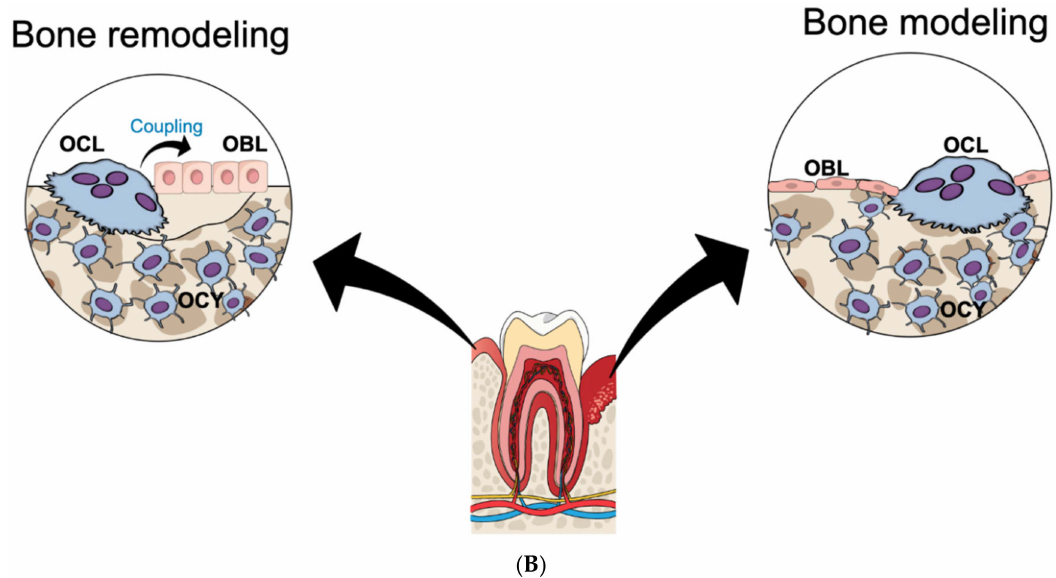
Figure 1. Bone modeling and remodeling: ( A ) During longitudinal bone growth, the diameter and thickness of the cortical bone are modeled to adjust to mechanical needs. To this end, osteoclasts (OCL) resorb bone in the endocortical region, while osteoblasts (OBL) deposit bone in the periosteal region. ( B ) In the alveolar bone surrounding the roots of the teeth, bone remodeling processes constantly occur to adapt to the mechanical needs of mastication ( left ). This process involves mechanical sensing by the osteocytes (OCY). Under conditions of inflammation, as in periodontitis, bone resorption is uncoupled from bone formation, resulting in bone modeling with loss of alveolar bone surrounding the root of the teeth ( right